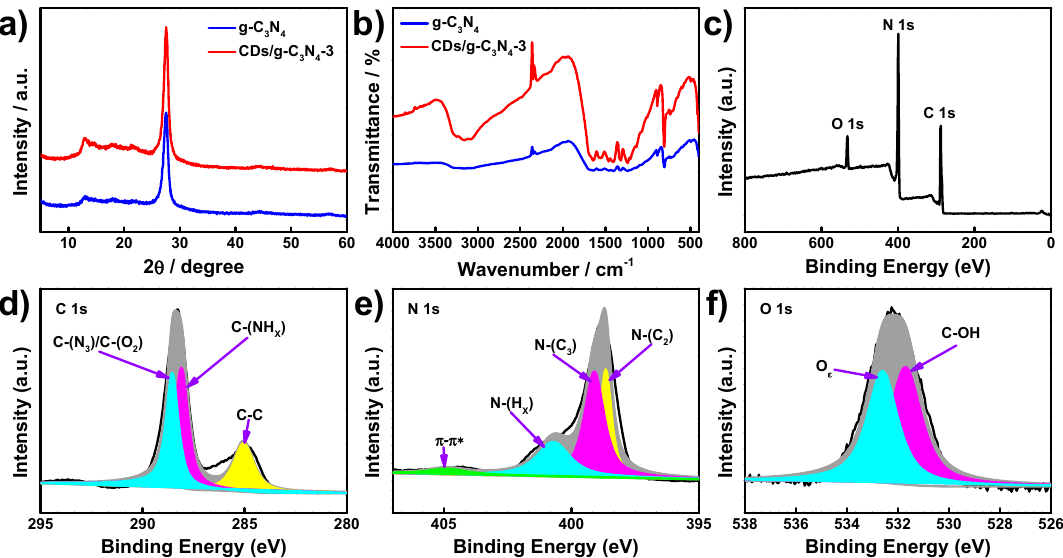
Figure 2. XRD patterns ( a ) and FTIR spectra ( b ) of g-C 3 N 4 and CDs/g-C 3 N 4 , XPS survey spectrum ( c ), and high-resolution XPS spectra of C 1 s ( d ), N 1 s ( e ), and O1 s ( f ) for CDs/g-C 3 N 4 . Figure 2b exhibits the FTIR spectra of pristine g-C 3 N 4 and CDs/g-C 3 N 4 composites. Multiple peaks from 1200 to 1700 cm − 1 , which formed both on g-C 3 N 4 and CDs/g-C 3 N 4 composites, correspond to the stretching vibration of heptazine-derived repeating units and C–N or C–NH–C groups. The peaks at 806.1 cm − 1 reflect the flexural vibrations of triazine units, and the wide peak that emerges at 3000–3500 cm − 1 is ascribed to NH 2 or NH groups [33,36]. In comparison with g-C 3 N 4 and CDs/g-C 3 N 4 composites, the obtained FTIR spectra are similar in shape, which indicates that the decoration of CDs does not change the chemical structures of g-C 3 N 4 . It should be noted that the adsorption peaks